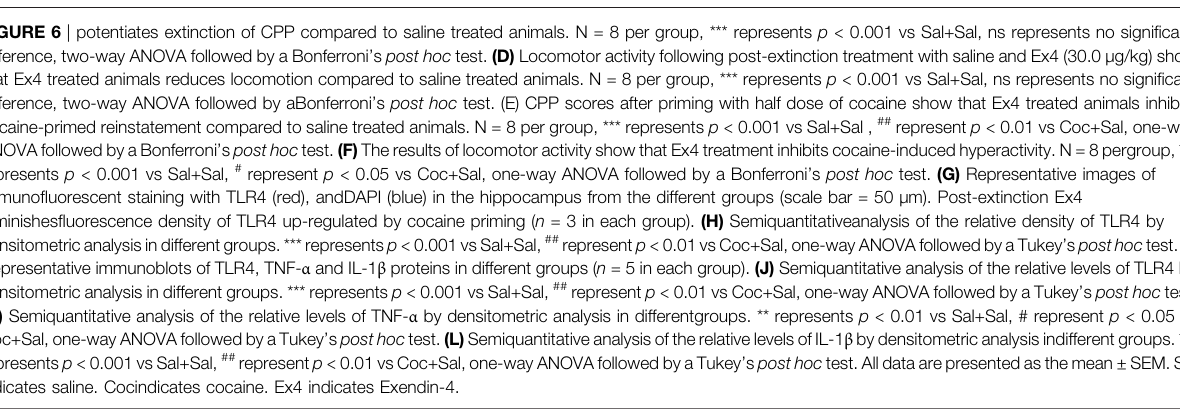
FIGURE 6 | potentiates extinction of CPP compared to saline treated animals. N (cid:2) 8 per group, *** represents p < 0.001 vs Sal+Sal, ns represents no signi fi cant difference, two-way ANOVA followed by a Bonferroni ’ s post hoc test. (D) Locomotor activity following post-extinction treatment with saline and Ex4 (30.0 μ g/kg) show that Ex4 treated animals reduces locomotion compared to saline treated animals. N (cid:2) 8 per group, *** represents p < 0.001 vs Sal+Sal, ns represents no signi fi cant difference, two-way ANOVA followed by aBonferroni ’ s post hoc test. (E) CPP scores after priming with half dose of cocaine show that Ex4 treated animals inhibits cocaine-primed reinstatement compared to saline treated animals. N (cid:2) 8 per group, *** represents p < 0.001 vs Sal+Sal , ## represent p < 0.01 vs Coc+Sal, one-way ANOVAfollowedbyaBonferroni ’ s posthoc test. (F) Theresultsoflocomotoractivity showthatEx4treatment inhibitscocaine-inducedhyperactivity.N (cid:2) 8pergroup,*** represents p < 0.001 vs Sal+Sal, # represent p < 0.05 vs Coc+Sal, one-way ANOVA followed by a Bonferroni ’ s post hoc test. (G) Representative images of immuno fl uorescent staining with TLR4 (red), andDAPI (blue) in the hippocampus from the different groups (scale bar (cid:2) 50 μ m). Post-extinction Ex4 diminishes fl uorescence density of TLR4 up-regulated by cocaine priming ( n (cid:2) 3 in each group). (H) Semiquantitativeanalysis of the relative density of TLR4 by densitometricanalysisindifferentgroups.***represents p < 0.001vsSal+Sal, ## represent p < 0.01vsCoc+Sal,one-wayANOVAfollowedbyaTukey ’ s posthoc test. (I) Representative immunoblots of TLR4, TNF- α and IL-1 β proteins in different groups ( n (cid:2) 5 in each group). (J) Semiquantitative analysis of the relative levels of TLR4 by densitometric analysis in different groups. *** represents p < 0.001 vs Sal+Sal, ## represent p < 0.01 vs Coc+Sal, one-way ANOVA followed by a Tukey ’ s post hoc test. (K) Semiquantitative analysis of the relative levels of TNF- α by densitometric analysis in differentgroups. ** represents p < 0.01 vs Sal+Sal, # represent p < 0.05 vs Coc+Sal,one-wayANOVAfollowedbyaTukey ’ s posthoc test. (L) SemiquantitativeanalysisoftherelativelevelsofIL-1 β bydensitometricanalysisindifferentgroups.*** represents p < 0.001vsSal+Sal, ## represent p < 0.01vsCoc+Sal,one-wayANOVAfollowedbyaTukey ’ s posthoc test.Alldataarepresentedasthemean ± SEM.Sal indicates saline. Cocindicates cocaine. Ex4 indicates